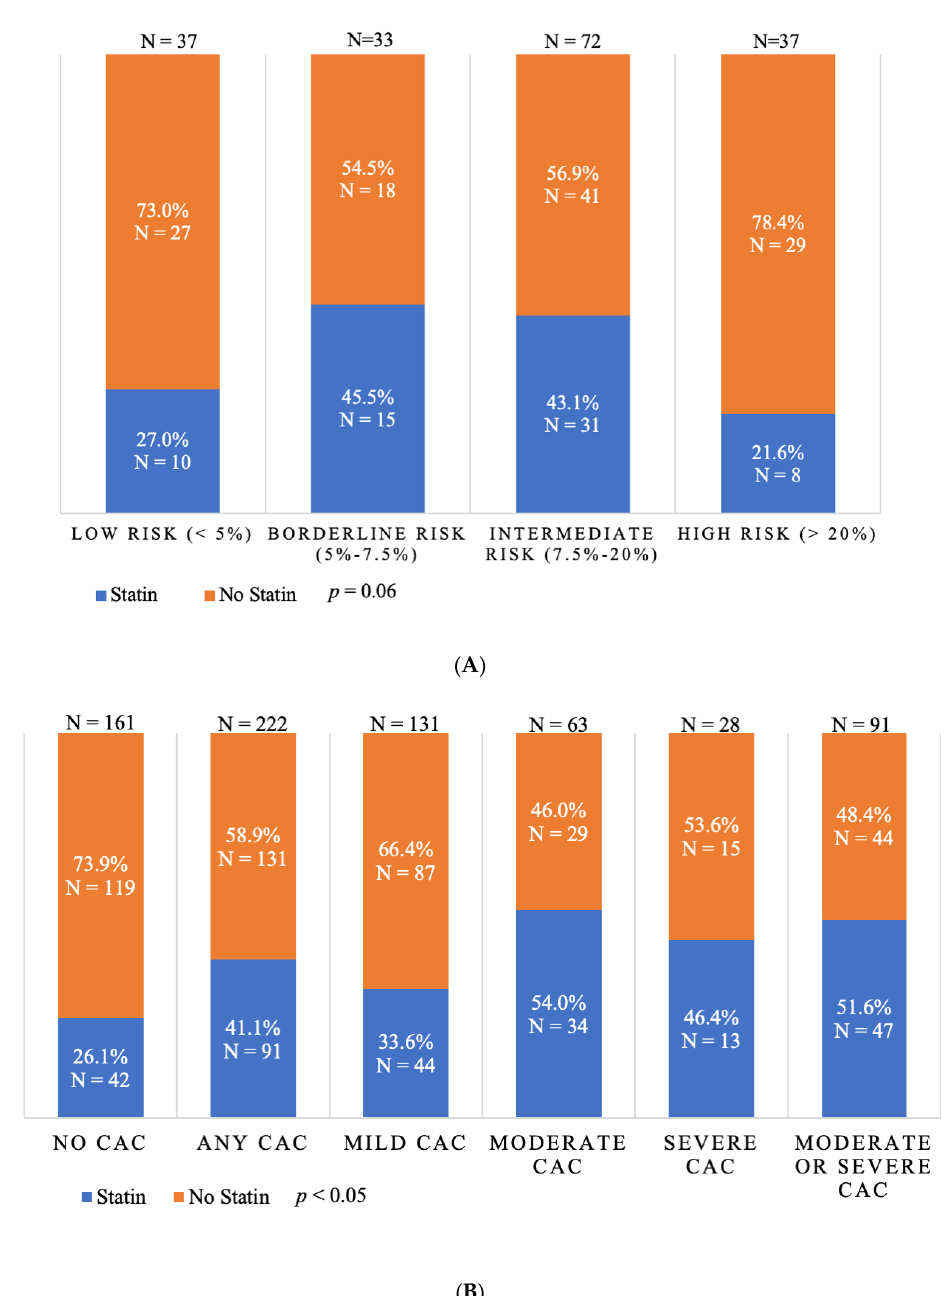
Figure 4. ( A ) Statin therapy use based on 10-year ASCVD risk and statin therapy distribution across different levels of 10-year ASCVD risk among subjects without ASCVD, p = 0.06. ( B ) Statin therapy distribution across different levels of CAC on CTPV among patients without a history of ASCVD, p < 0.05. CAC—coronary artery calcification, CTPV—computed tomography of the pulmonary veins,